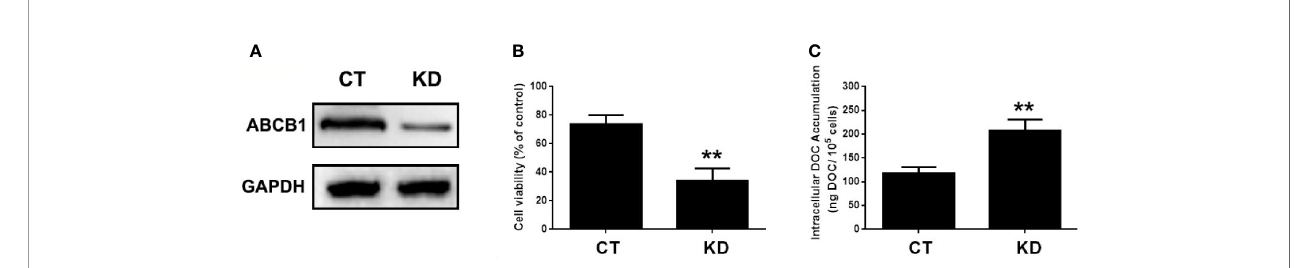
FIGURE 8 | The involvement of ABCB1 in the potentiated effect of MELK-FoxM1 signaling in MDA-MB-231/DOC cells. MDA-MB-231/DOC cells with maternal embryonic leucine-zipper kinase (MELK) and FoxM1 co-transfection were transfected with or without ABCC1 siRNA and then treated with docetaxel (DOC) combined MA for 24 h. (A) The expression of ABCB1 in cells with ABCB1 knockdown was assessed by western blot analysis. (B) Cell viability was assessed by MTT assay. (C) Cellular DOC accumulation was evaluated by high performance liquid chromatography (HPLC) analysis. ** p < 0.01 vs. CT. All data were presented as means ± SD with three independent experiments, and triplicate repeats were included in each experiment. CT, control; KD, knockdown.